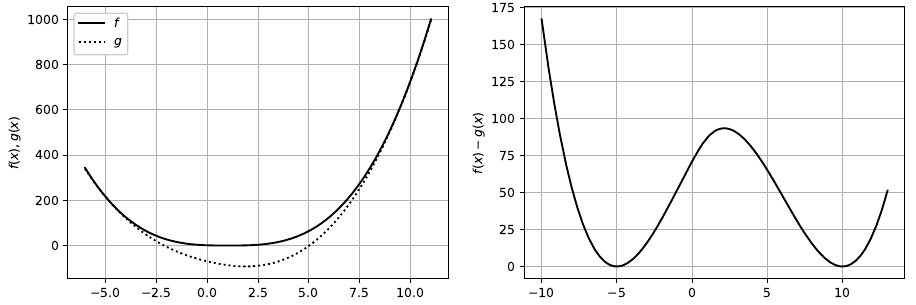
Figure 3. The graphs of the functions f ( x ) = | x − 1 | 3 and g ( x ) = a + bx + cx 2 + d | x | 3 from Lemma 1 ( left ) and the graph of the difference f − g ( right ) for u = − 5, v = 10 ( d > 0). The unique minimum point of g lies between the tangency points u and v .